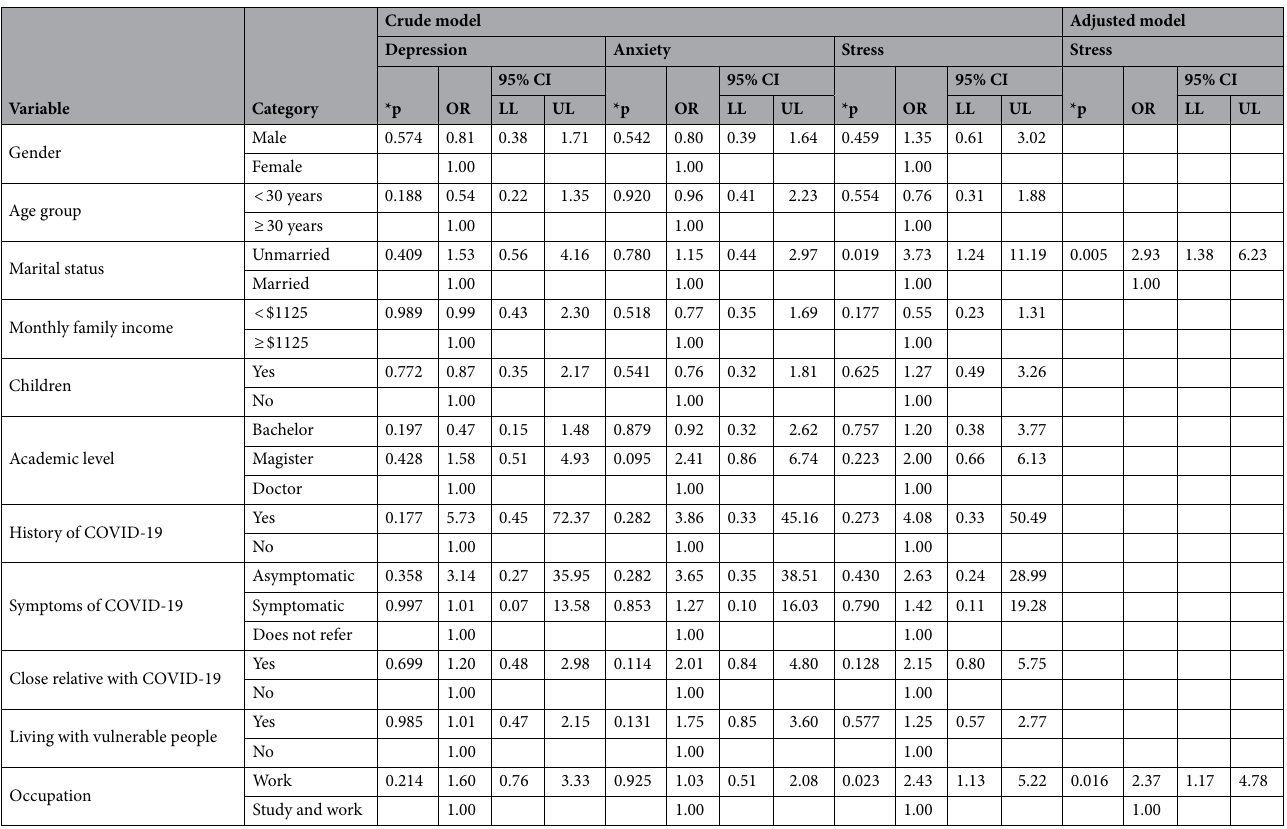
Table 6. Multivariate logistic regression model of Depression, Anxiety and Stress in dental professionals according to their associated factors. *p < 0.05, significant association according to regression model. The model effect size (Nagelkerke’s R2) for stress was 0.225.